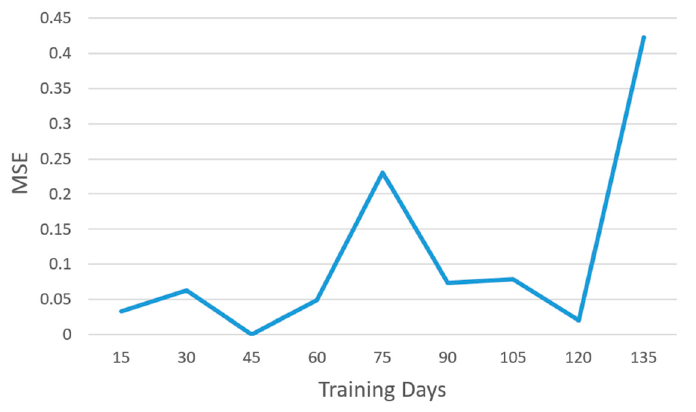
Figure 11. Mean Square Error (MSE) between predicted and actual values versus the training days.